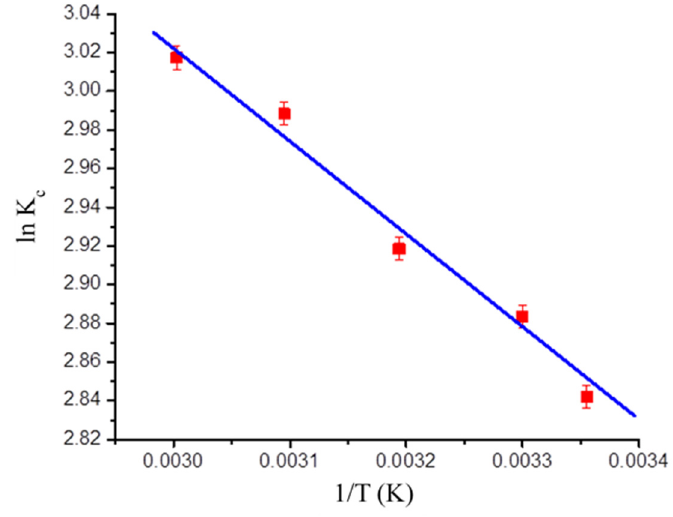
Figure 8. van’t Hoff plot for BG adsorption onto GO-PANI. Table 4. Thermodynamic parameters for BG adsorption on GO-PANI.